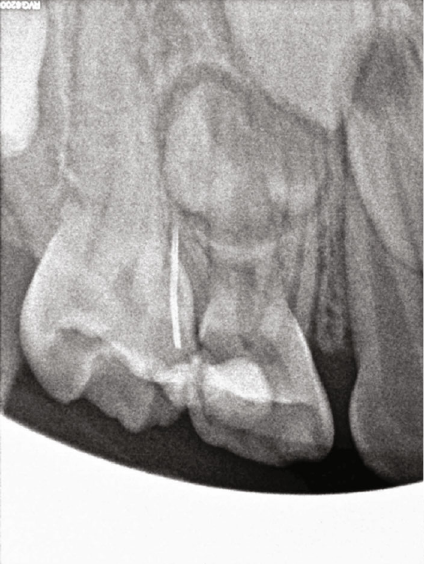
Figure 2: The periapical radiograph shows the exact location of a broken tool between teeth 55 and